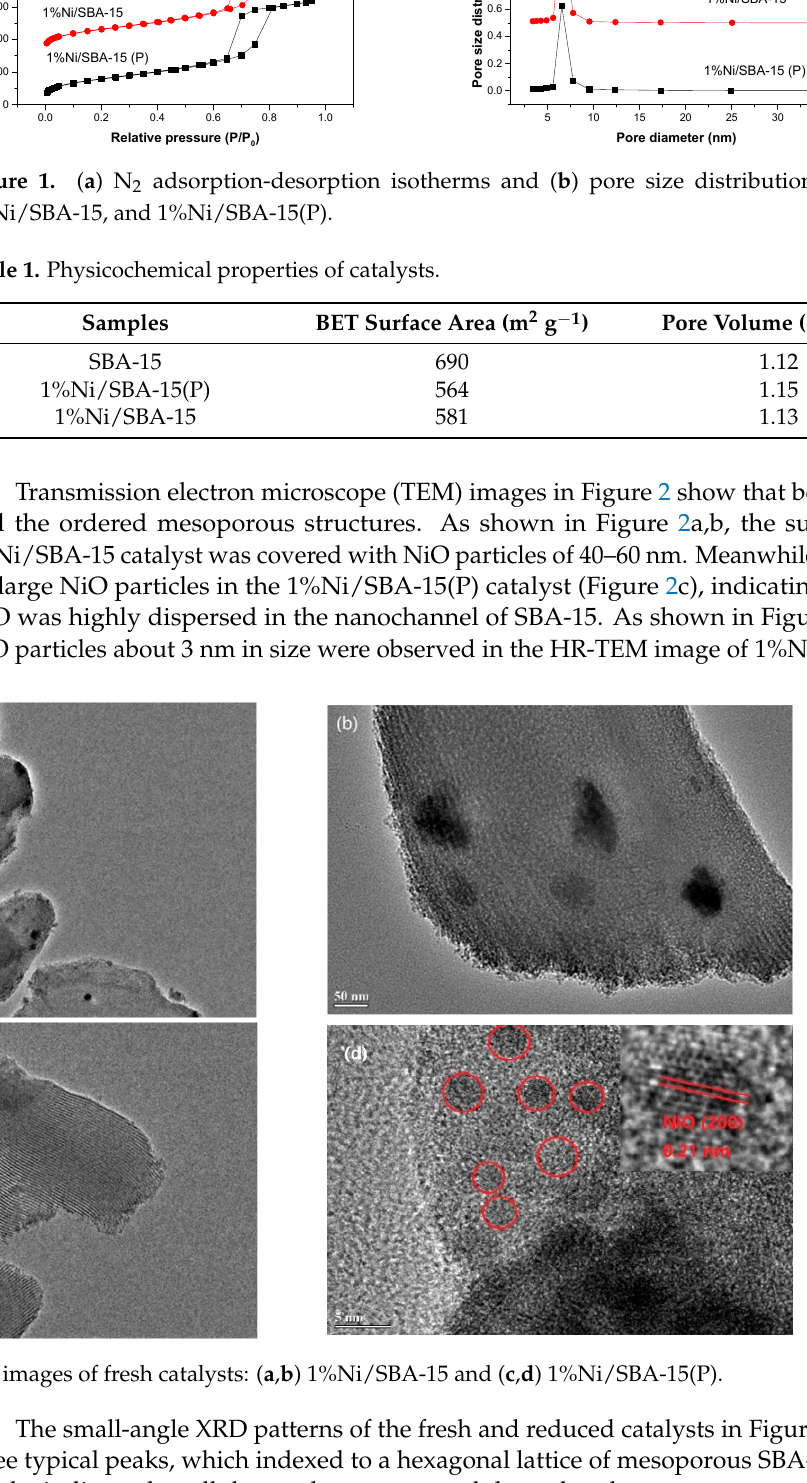
Figure 2. TEM images of fresh catalysts: ( a , b ) 1%Ni/SBA-15 and ( c , d ) 1%Ni/SBA-15(P). The small-angle XRD patterns of the fresh and reduced catalysts in Figure 3a showed three typical peaks, which indexed to a hexagonal lattice of mesoporous SBA-15 [30]. The results indicate that all the catalysts possessed the ordered mesoporous structure. After reduction, angles of all reflection planes were moved toward higher angle, implying that d-spacing of SBA-15 support must have been